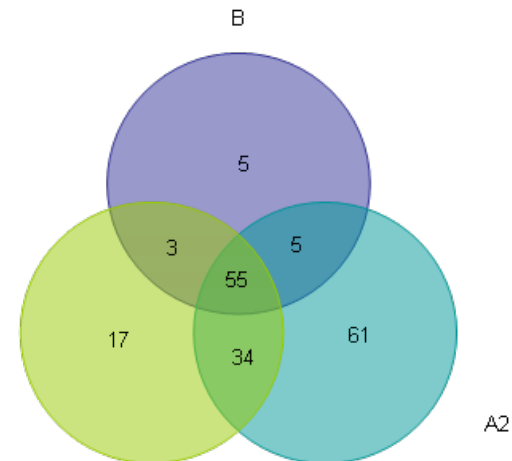
Figure 3. Venn diagram of the three extremely halophilic microbial samples. The number of the OTUs is shown inside the diagram. A total of 17, 5 and 61 unique OTUs were found in A1, B and A2, respectively, and 55 OTUs were shared among the three samples.